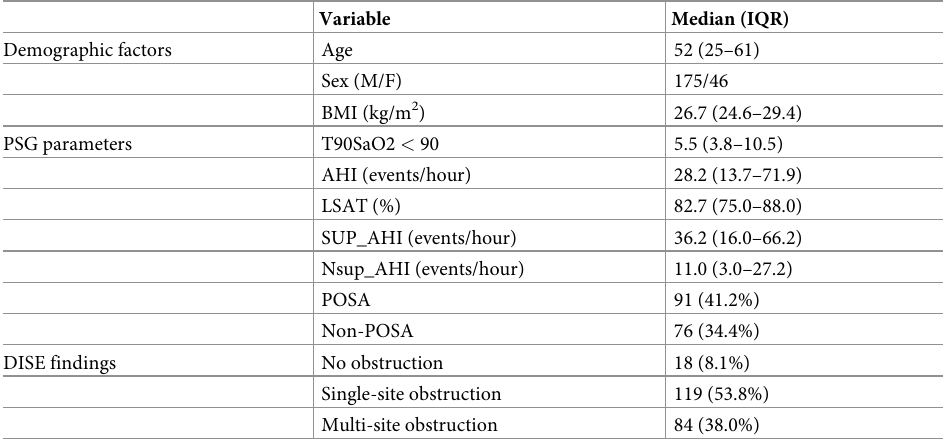
Table 1. Pretreatment clinical characteristics of the study population �